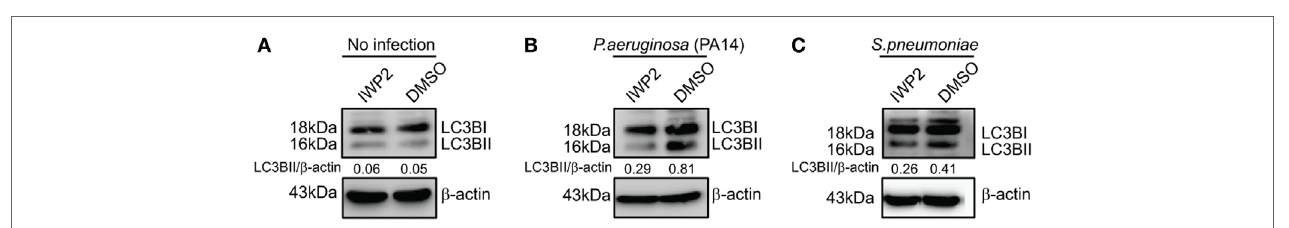
FigUre 7 | Inhibitor of Wnt production (IWP2) treatment correlates with reduced LC3BII accumulation in infected [ Pseudomonas aeruginosa (PA), Streptococcus pneumoniae (SP)] macrophages. (a) In absence of infection, IWP2 does not have significant effect on LC3BII accumulation on RAW 264.7 cells. (B,c) Effect of IWP2 treatment on LC3BII accumulation in PA14 (B) and SP (c) infected macrophages.